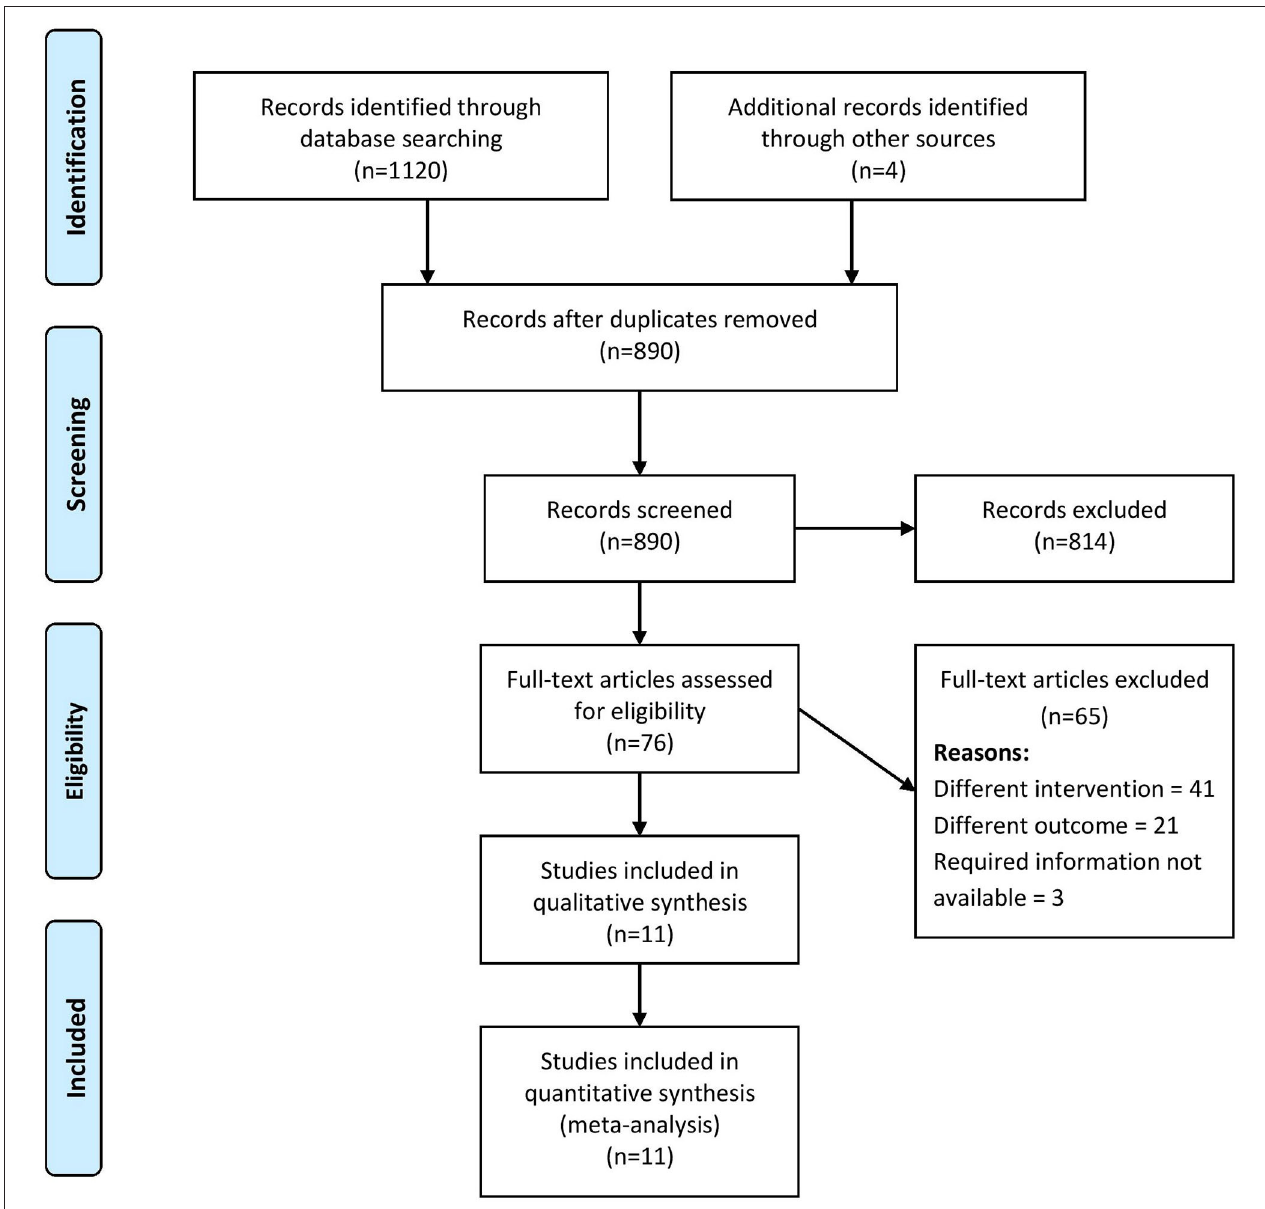
FIGURE 1 | PRISMA flow chart showing the selection of studies for the current review ( n = 11).